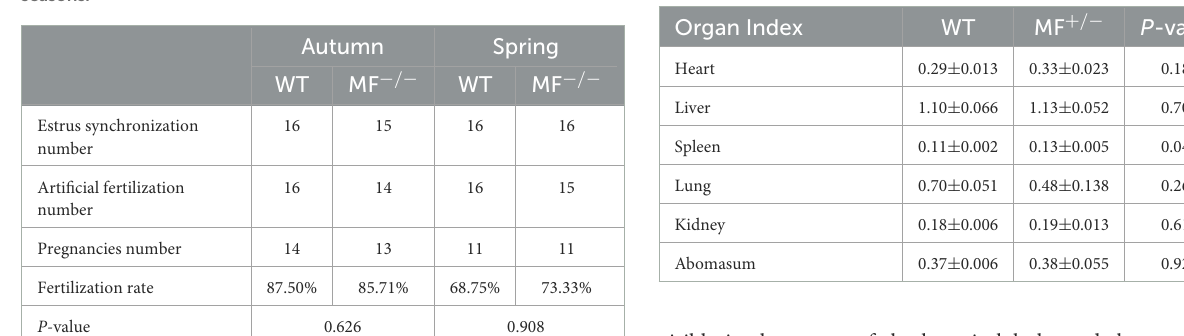
TABLE 2 Organ indexes in WT and MF +/– sheep